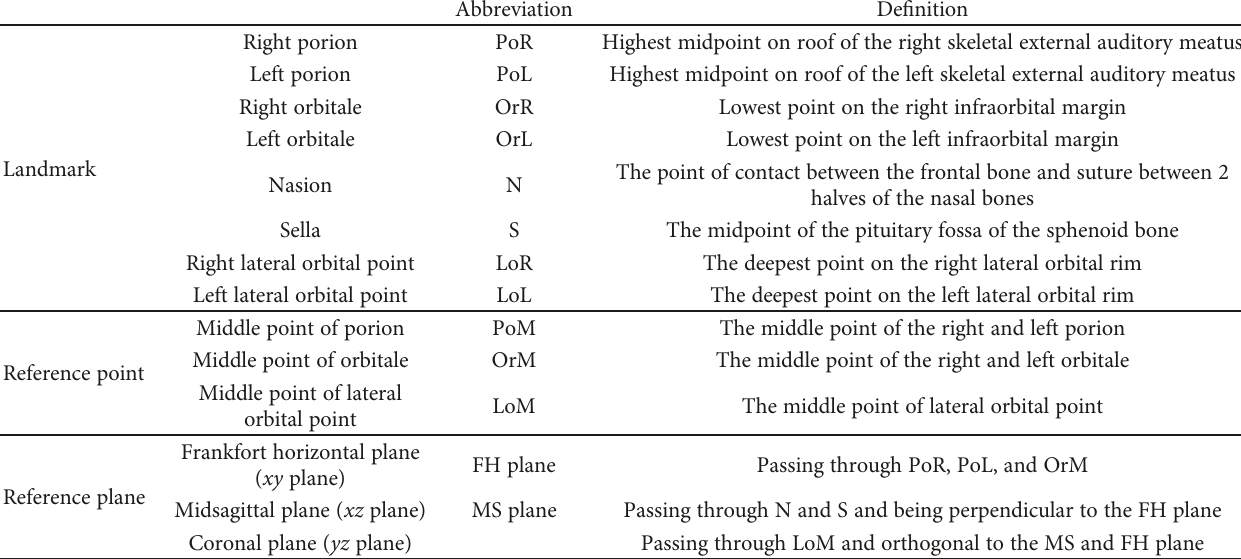
Table 1: The landmarks, reference points, and planes of the 3D coordinate